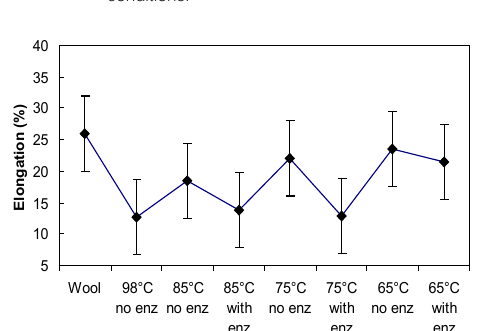
Figure 7. Elongation measurements on wool yarn dyed in different